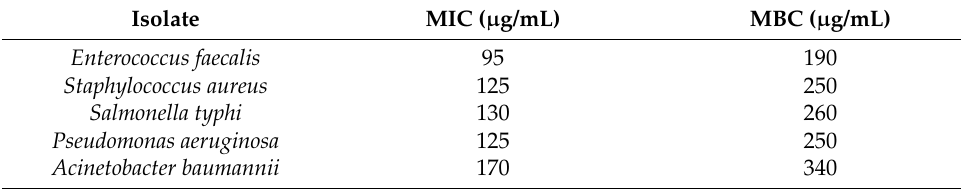
Table 8. MIC and MBC of aniseed extract against isolated